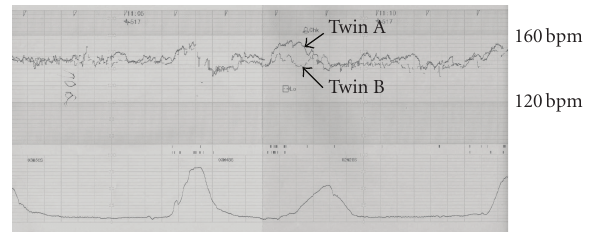
Figure 1: Fetal heart rate tracings during labor the latent phase of labor showing reassuring fetal heart rate patterns in both twins.